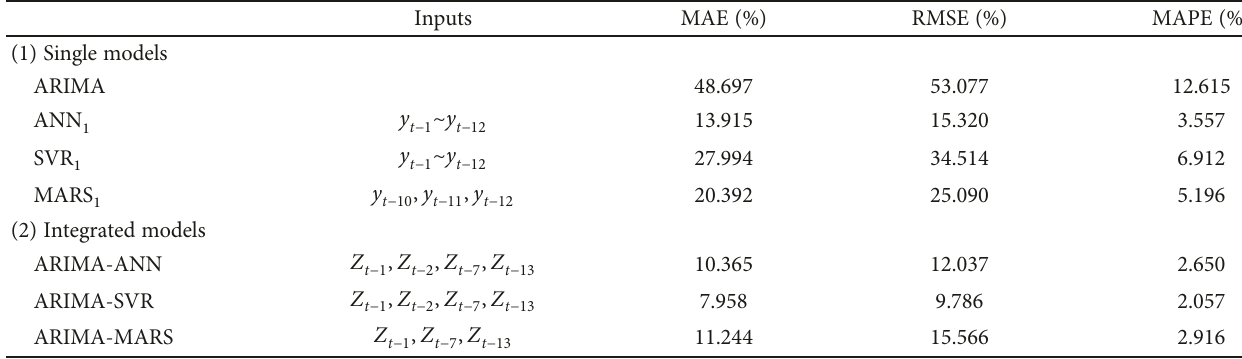
Table 16: Performance comparison of various models for rice price forecasting.